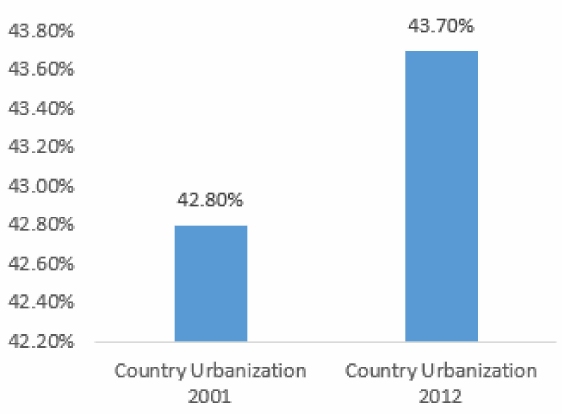
Figure 2. The country’s urbanization rate, adapted from [12,34].